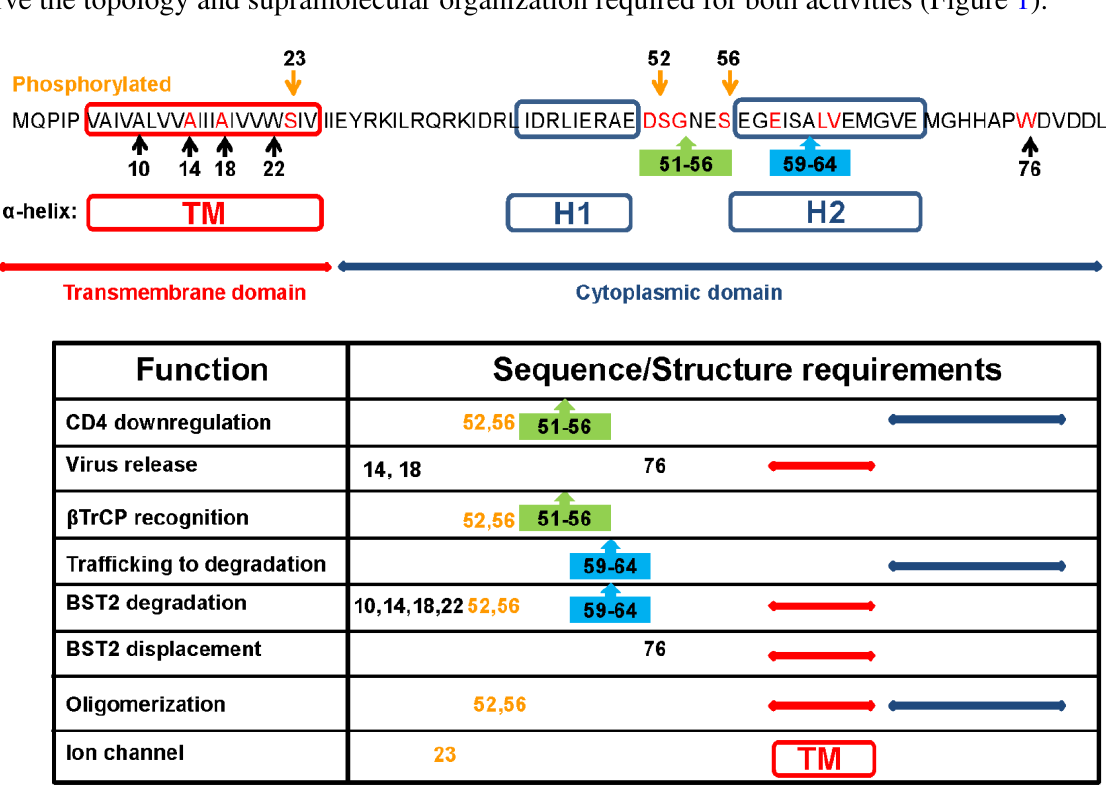
Figure 1. Sequence and structure requirements for Viral protein U (Vpu) functionality. Vpu from the HXB2 strain is the reference amino acid sequence showing conserved amino acid (red), motifs (boxes), structural domains, and predicted helices. Numbers refer to amino acid positions. Table summarizes the consensus published data of each function. Each function was separately characterized, using different approaches. Further coordinated studies are needed to compare requirements of these